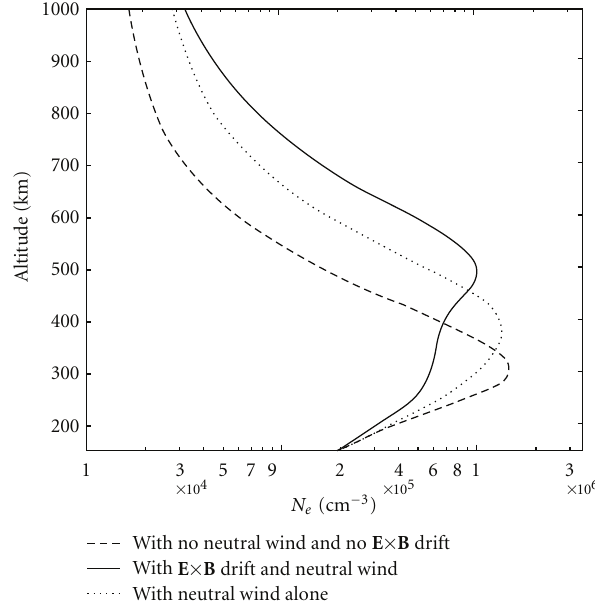
Figure 19: Electron density profiles from model calculations with E × B drift and no neutral wind (dashed curve), with neutral wind and no E × B drift (dotted curve), and with both E × B drift and neutral wind (split curve) (from Balan et al. [35]). The profiles correspond to 11:00 LT at 4 ◦ magnetic latitude at the longitude of Fortaleza during June solstice at low solar activity. Note that the F3 layer does not form when the wind alone is used (dotted